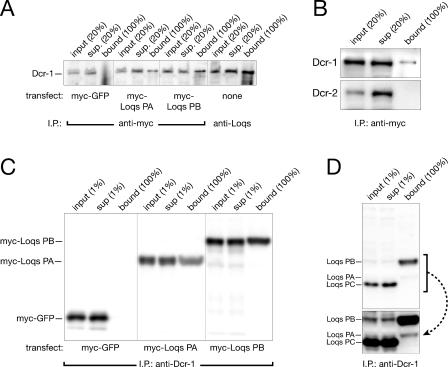
Loqs and Dcr-1 Are Present in a Common Protein Complex in S2-Cells(A) Dcr-1 associates with myc-tagged Loqs PA or PB, and with endogenous Loqs protein. Immunoprecipitation with anti-myc or anti-Loqs antibody was performed using lysates from S2 cells transfected with the indicated expression plasmid. Dcr-1 was detected by Western blotting.(B) myc-tagged Loqs PB stably associates with Dcr-1 but not Dcr-2. S2 cells were transfected with plasmid expressing myc-tagged Loqs PB, then lysed and immunoprecipitated with anti-myc antibody. The immunoprecipitates were analyzed by Western blotting using anti-Dcr-1 or anti-Dcr-2 antibodies.(C) S2 cells were transfected with plasmid expressing myc-tagged GFP, Loqs PA, or Loqs PB, then extracted and immunoprecipitated with anti-Dcr-1 antibody. The immunoprecipitates were analyzed by Western blotting using anti-myc antibody.(D) Anti-Dcr-1 antibody was used to immunoprecipitate Dcr-1 and associated proteins from S2 cell lysates, and the immunoprecipitates were analyzed by Western blotting using anti-Loqs antibody to detect endogenous Loqs protein. The major Loqs protein isoform recovered was Loqs PB. In a longer exposure (bottom panel), a band corresponding in size to Loqs PA is visible. The most abundant Loqs isoform the input sample, Loqs PC, which lacks the third dsRBD, did not immunoprecipitate with Dcr-1, suggesting that the third dsRBD is required for the association of Loqs with Dcr-1.